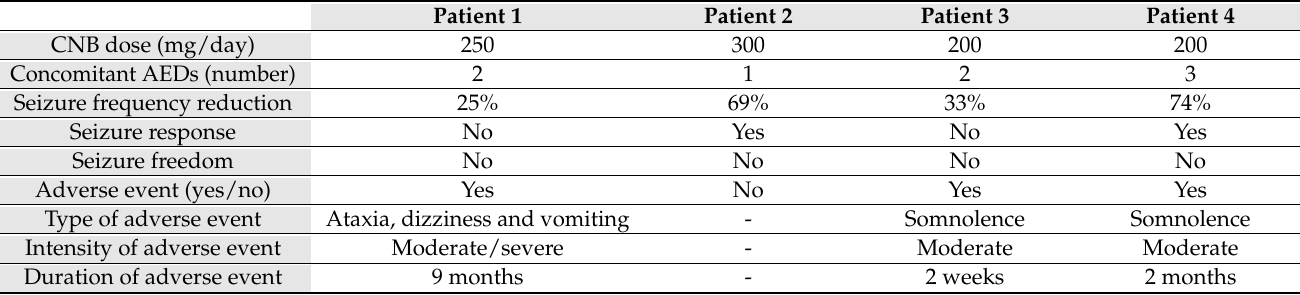
Table 2. Efficacy and tolerability outcomes at 12 months from starting